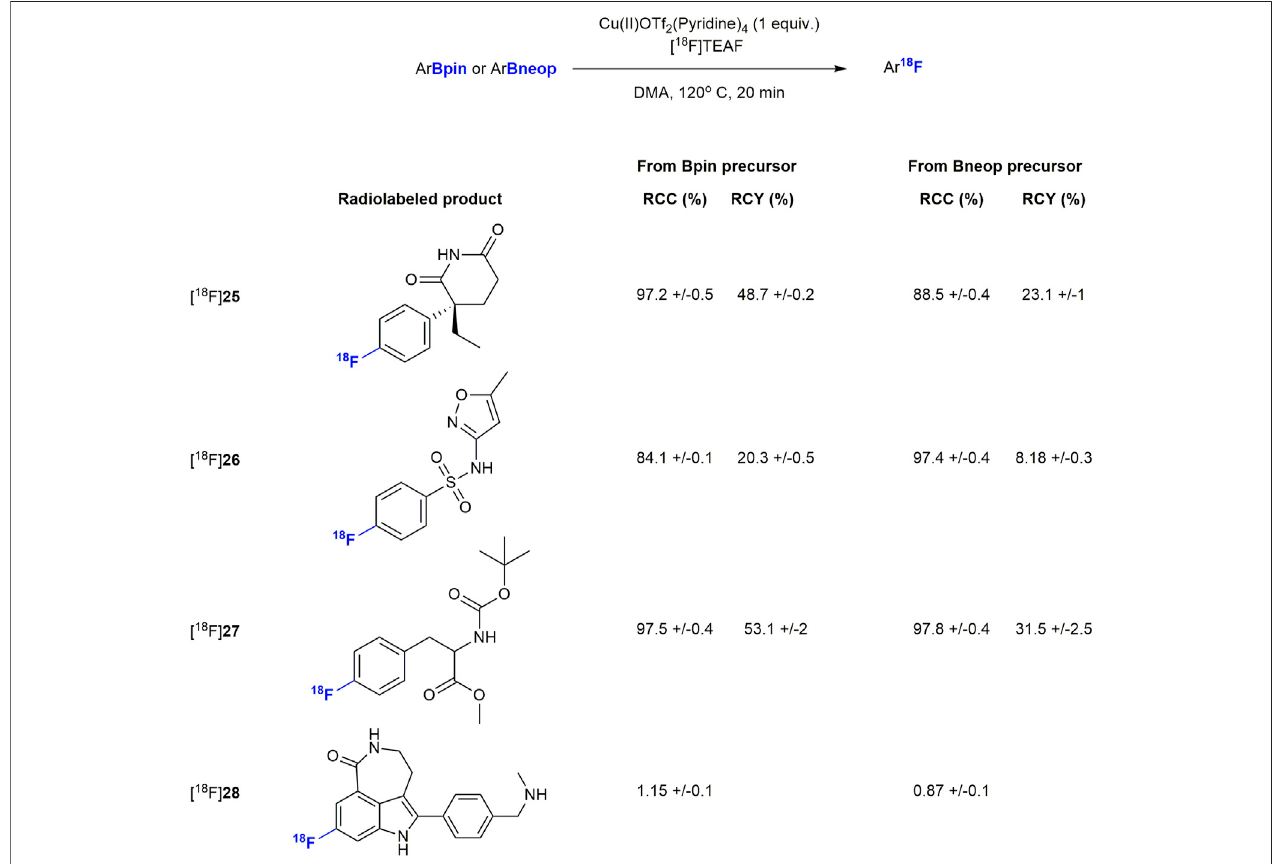
FIGURE 2 | Radiolabeling of drug compounds. Results are all averages of two runs ( n = 2).